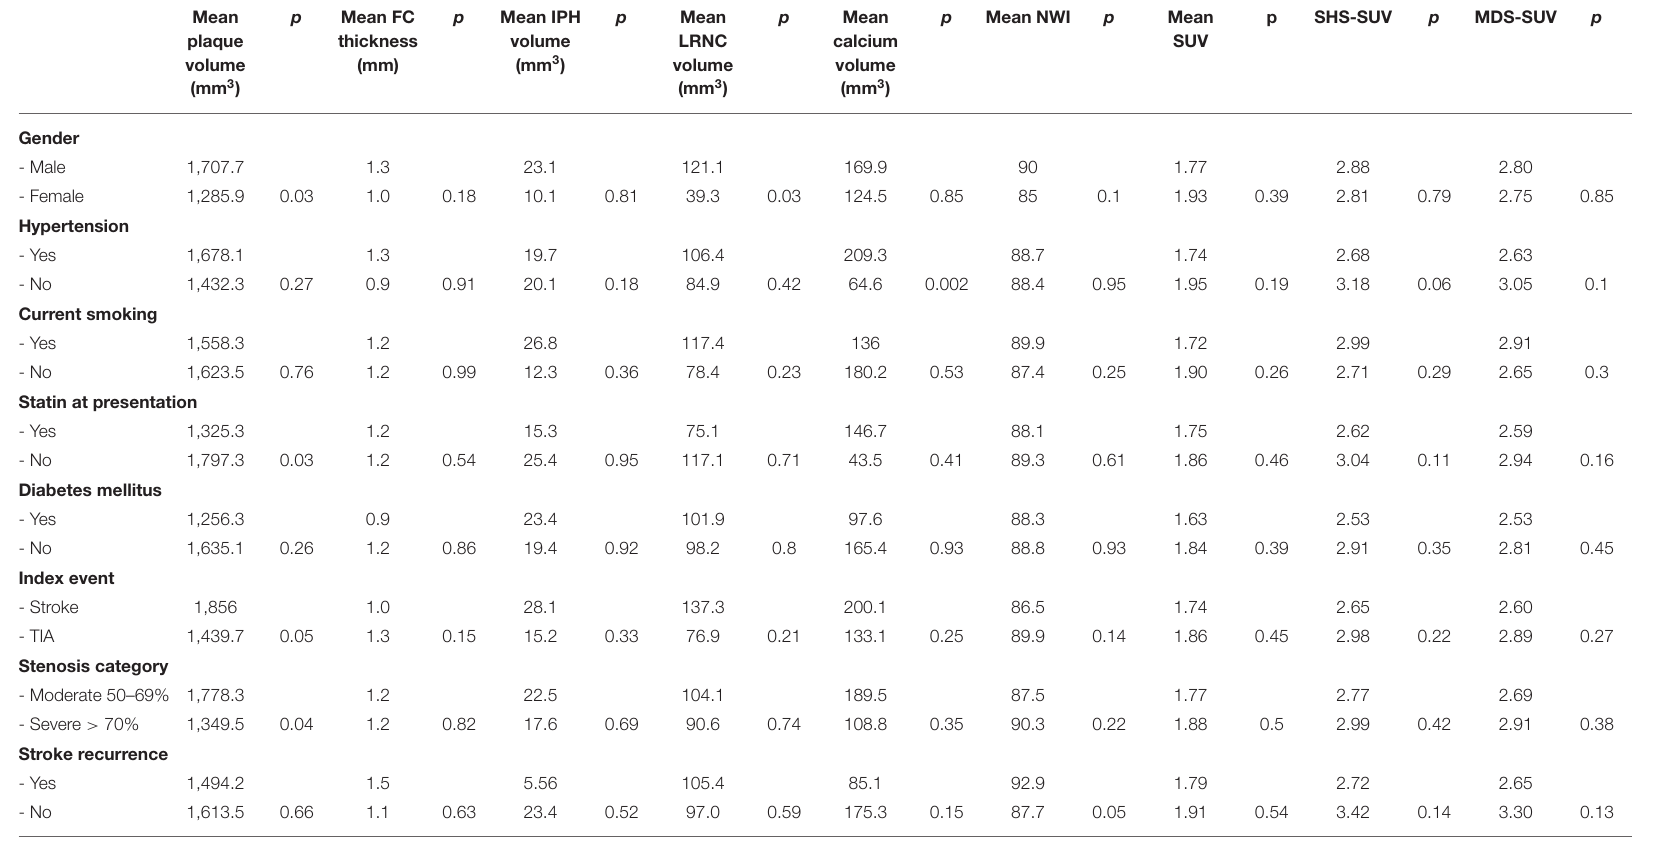
TABLE 2 | Distribution of MRI plaque features and clinical